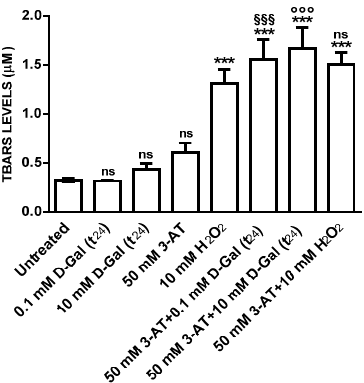
Figure 3. TBARS levels ( μ M) in untreated (control) and in 0.1 and 10 mM D -Gal (t 24 )-treated withorwithout50mM3-ATpreincubation. ns, notsignificantversuscontrolor10mMH 2 O 2 ; *** , p < 0.001 erythrocytes, with or without 50 mM 3-AT preincubation. ns, not significant versus control or 10 mM ◦◦◦ versus control, §§§ p < 0.001 versus 0.1 mM d -Gal (t 24 ) and , p < 0.001 versus 10 mM d -Gal (t 24 ) as H 2 O 2 ; *** , p < 0.001 versus control, §§§ p < 0.001 versus 0.1 mM D -Gal (t 24 ) and °°° , p < 0.001 versus 10 mM D -Gal (t 24 ) as determined by one way ANOVA followed by Bonferroni’s post hoc test ( n = 6). determined by one way ANOVA followed by Bonferroni’s post hoc test ( n =